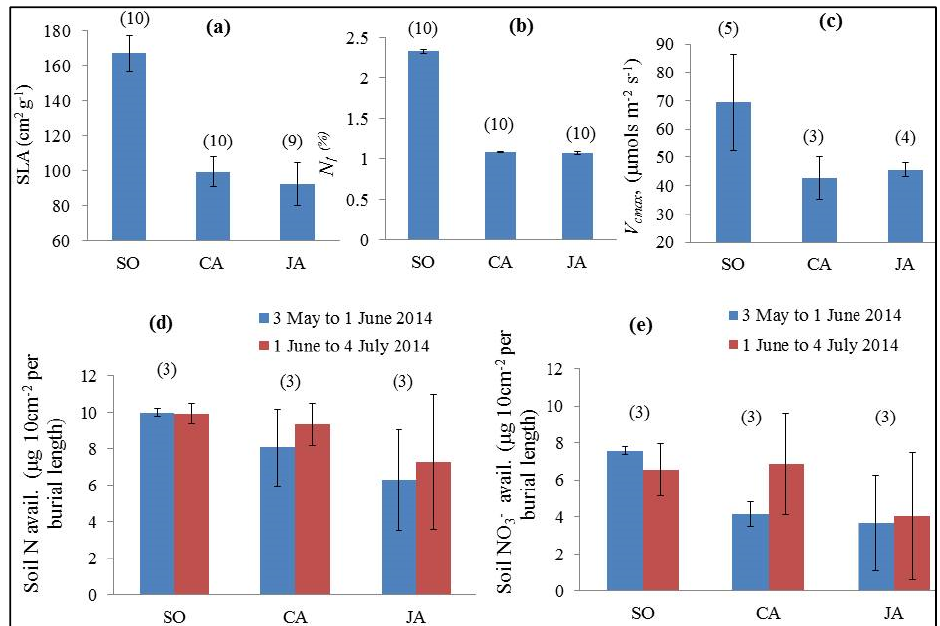
Figure 6. Field measurements for ( a ) specific leaf area; ( b ) percentage leaf Nitrogen measured on 13 June 2014; ( c ) maximum carboxylation capacity measured during May–June 2014 for SO , CA and JA ; ( d ) available soil Nitrogen; and ( e ) soil available Nitrate in the SO , CA and JA root zone over the burial period. The values in the brackets show number of samples.